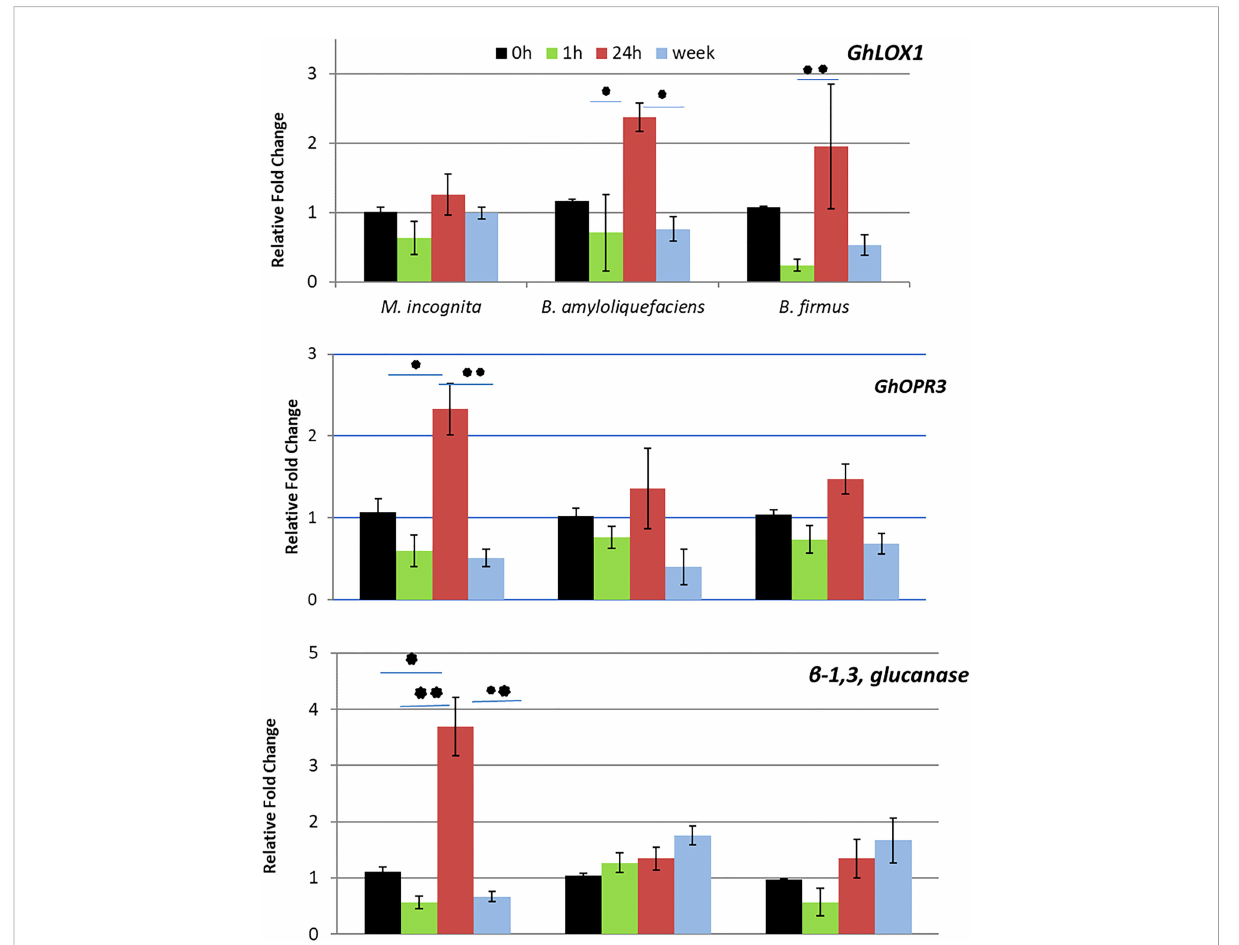
FIGURE 2 Results from the RT-qPCR depicting the relative fold change of GhLOX1, GhOPR3, b -1,3, glucanase in cotton at 0 hours (h), 1h, 24h and 1 week after inoculation of Meloidogyne incognita J2s, Bacillus amyloliquefaciens QST713 and B fi rmus I-1582. Fold change was calculated 2 − DD C T (Livak and Schmittgen, 2001) where the treated samples were compared to a negative control group and normalized with the reference gene histone H3. Asterisks represent signi fi cance as determined by a two way ANOVA performed in SAS 9.4 (* P ≤ 0.05; ** P ≤